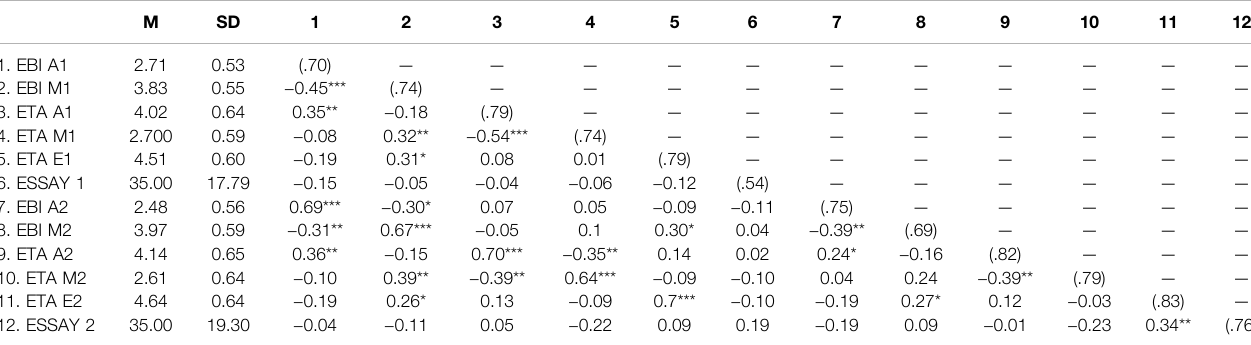
TABLE 4 | Descriptive statistics and correlations for the epistemological belief scales and the essays score at pre- and posttest for the whole